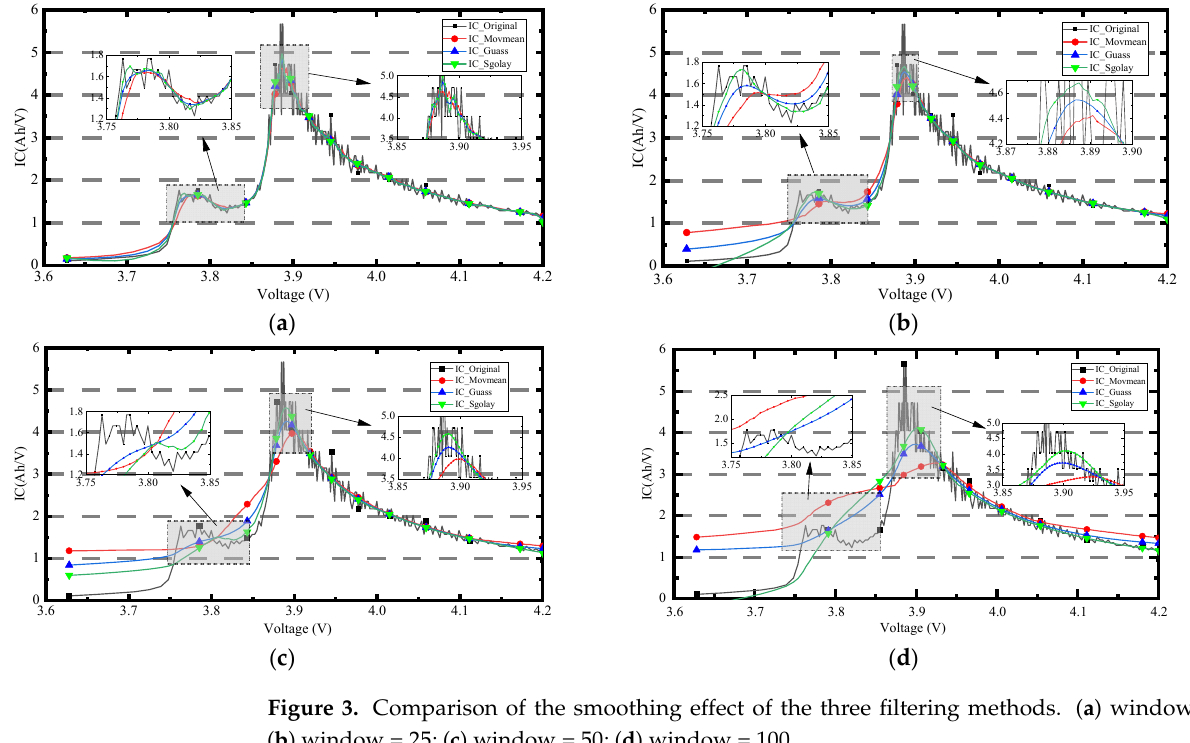
Figure 3. Comparison of the smoothing effect of the three filtering methods. ( a ) window = 10; ( b ) window = 25; ( c ) window = 50; ( d ) window = 100.